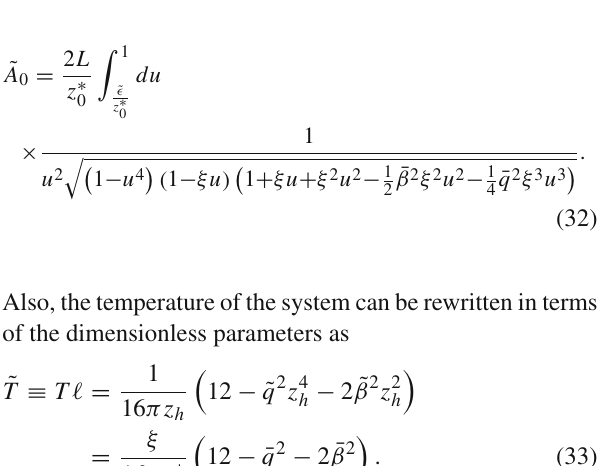
Fig. 1 The intersection of a deformed minimal surface by the electric field (Solid curve) with ˜ β = 1, ˜ M = 1 and ˜ q = 1: The dotted line denotes the minimal surface before applying the electric field. λ = 0 . 05 is taken for visualization and the right figure is the enlarged picture for the blue square near the